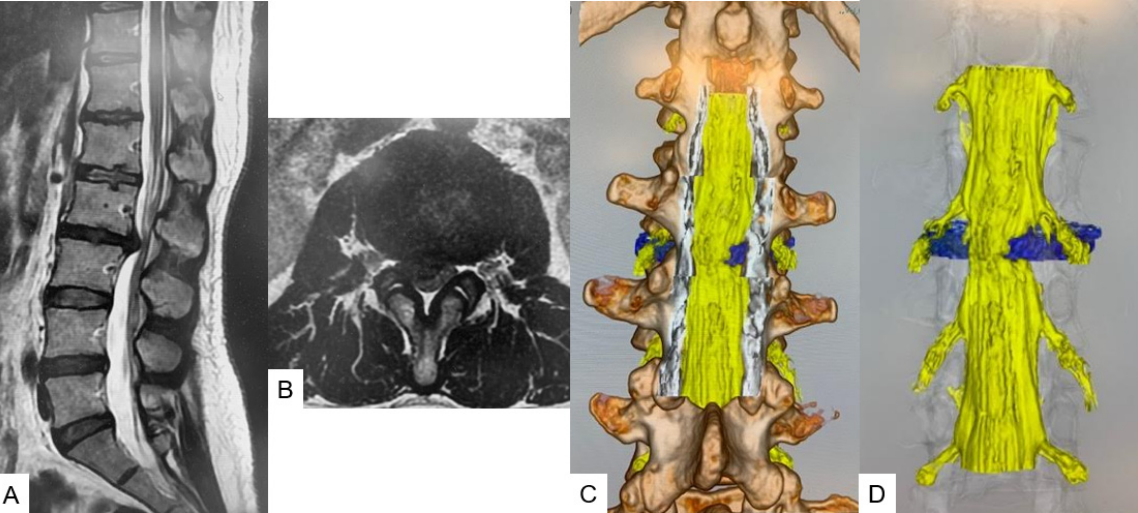
Figure 8. A 44-year-old female, right L2/3 paramedial disc herniation. ( A ): T2 weighted midsagittal MRI. ( B ): L2/3 T2 weighted axial MRI, ( C ): Posterior view. ( D ): Without bony structure.